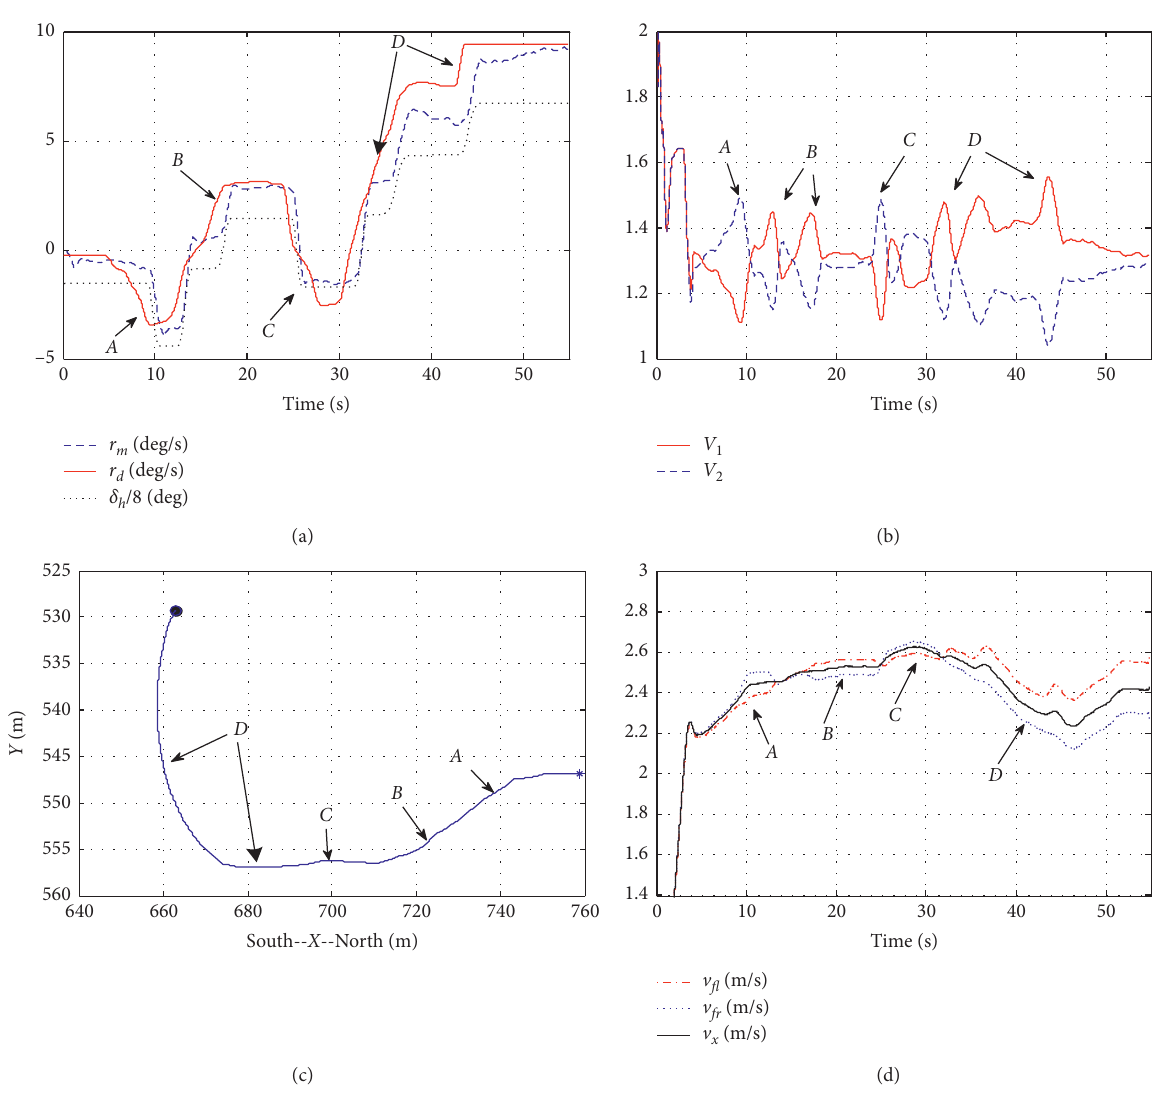
Figure 9: Yaw rate tracking with J-turn-like maneuver. (a) Time (s). (b) Time (s). (c) South- X -North. (d) Time